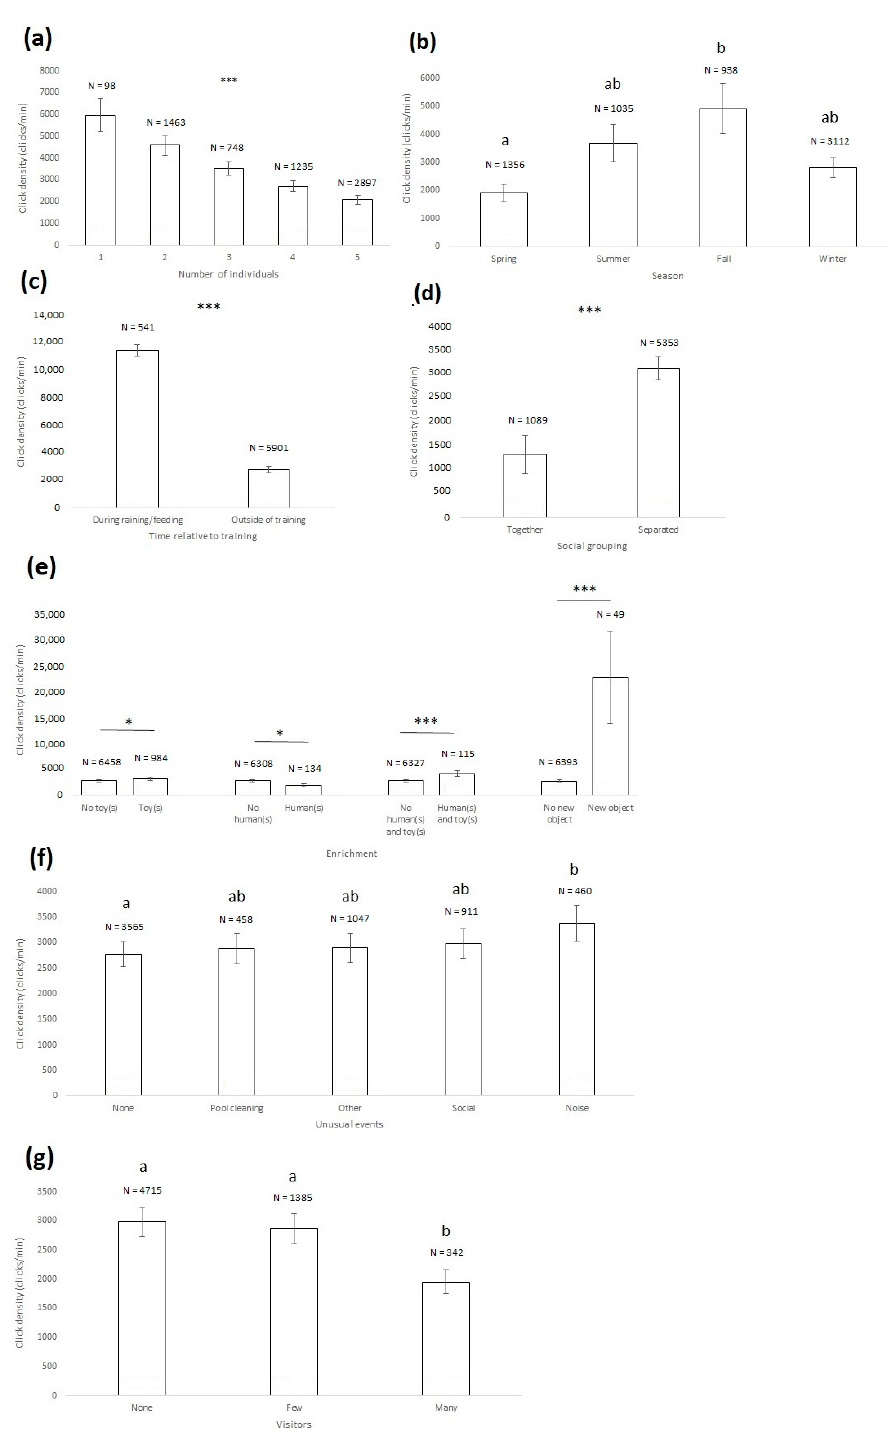
Figure 2. Click density average and 95% confidence intervals depending on the number of porpoises present in the pool ( a ) the season ( b ) the social grouping ( c ), the presence of enrichment ( d ) the time relative to training ( e ) the occurrence of unusual events ( f ) and the presence of visitors ( g ) *: p < 0.05, ***: p < 0.001; when pairwise tests were conducted within a context variable, click densities that share the same letter (a or b) do not differ significantly, whereas click densities that have no letter in common differ significantly (Wald chi-squared test with a sequential Bonferroni correction). N: number of one-minute samples. The presented data are not raw, but have been extracted from the generalized linear mixed-effects model.